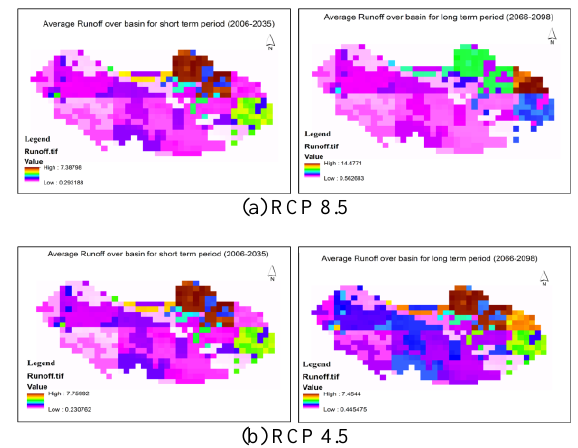
Figure 12. Spatial change in runoff under each scenario